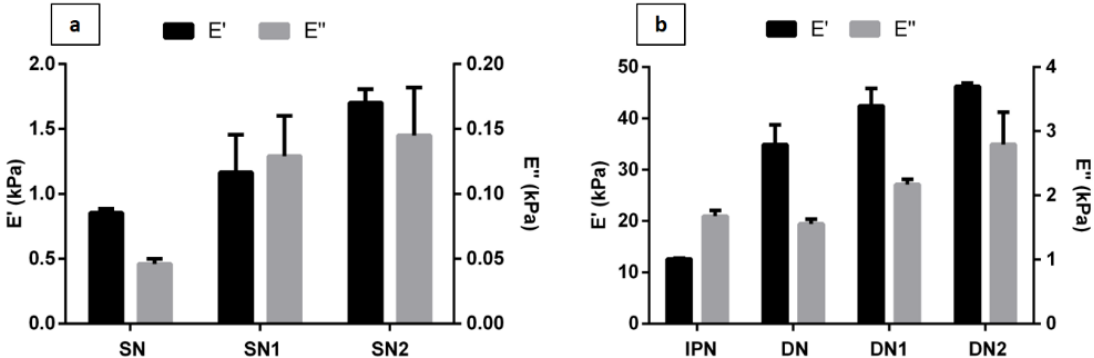
Figure 3. Results from DMA analysis. Storage modulus (E’) and loss modulus (E”) of ( a ) neat and composite SN hydrogels with different hydroxyapatite nanoparticles (HAp) concentrations; ( b ) interpenetrated polymer network (IPN), neat and composite DN hydrogels with different HAp concentrations. Data are expressed as mean value ± standard deviation.